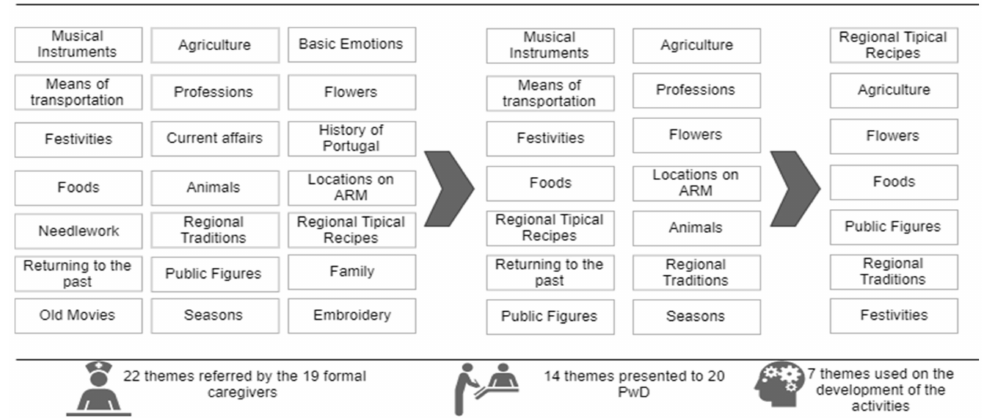
Figure 4. Themes given by the formal caregivers, themes presented to IwD, and themes used in the development of the activities (IwD’s favorites).